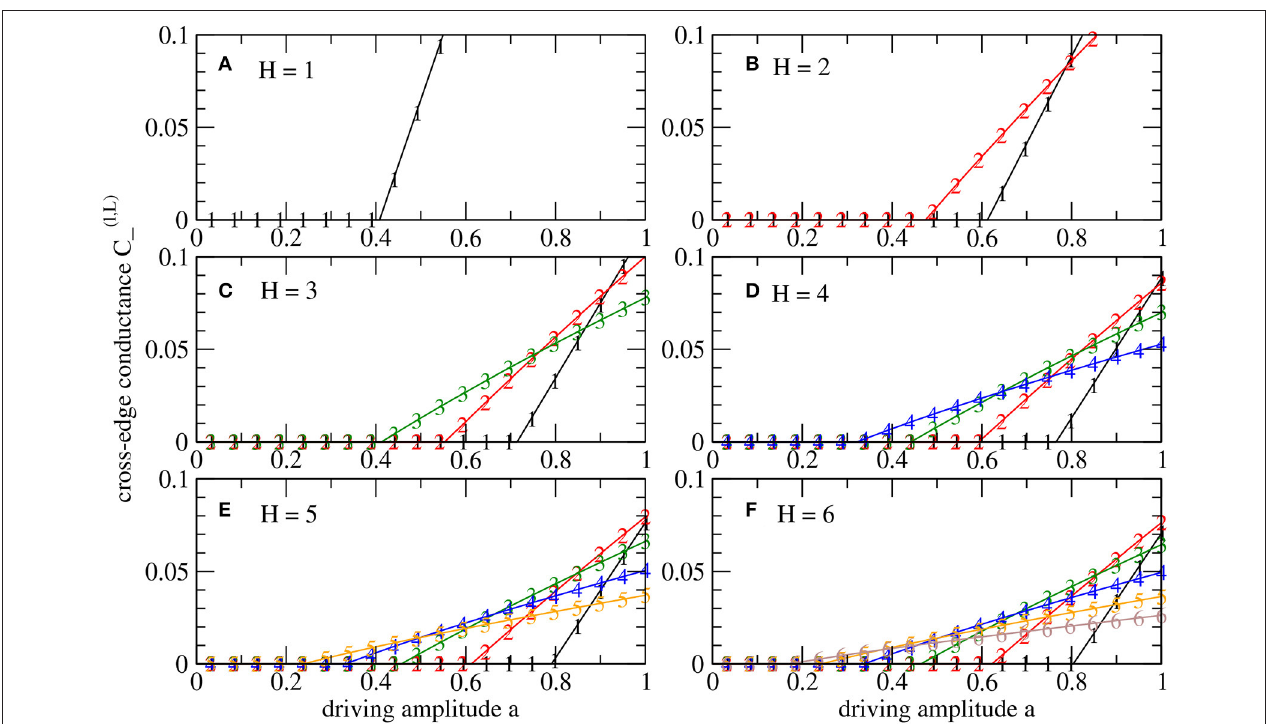
FIGURE 3 | Bifurcation diagrams for augmented tree systems ( H > 1) according to Figure 1C with dynamics under fast stochastic driving at the sinks. The conductances of cross-edges are shown for different levels l as defined in Figure 1 , i.e., from the root ( l parameter scans decreasing driving amplitude a from 1 to 0. (A–F) Distinguish systems with different heights H N 2 H + 1 1, i.e., N 127 nodes for H = − = =